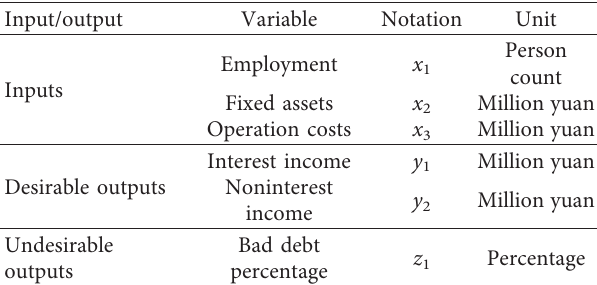
Table 2: Input and output